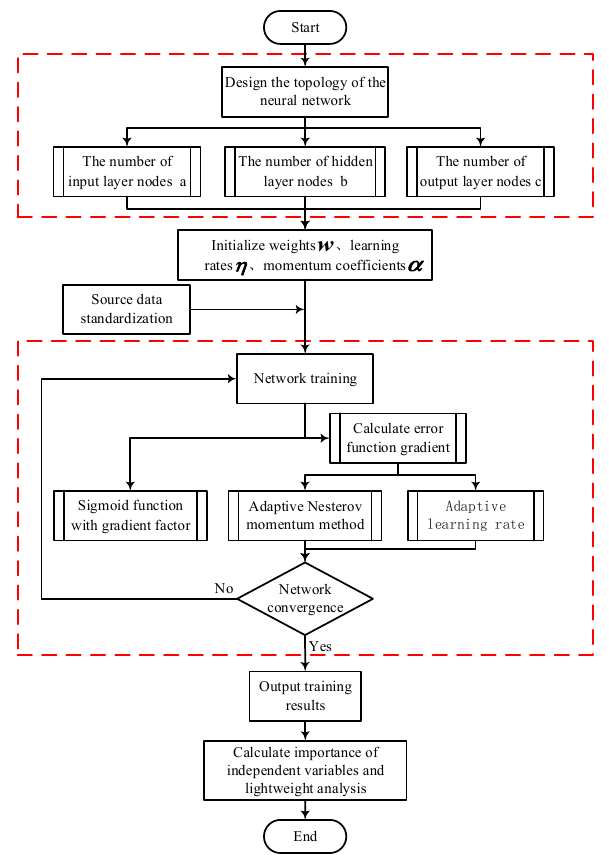
Figure 5. Flow chart of meso parameter lightweight modeling based on improved BP algorithm.